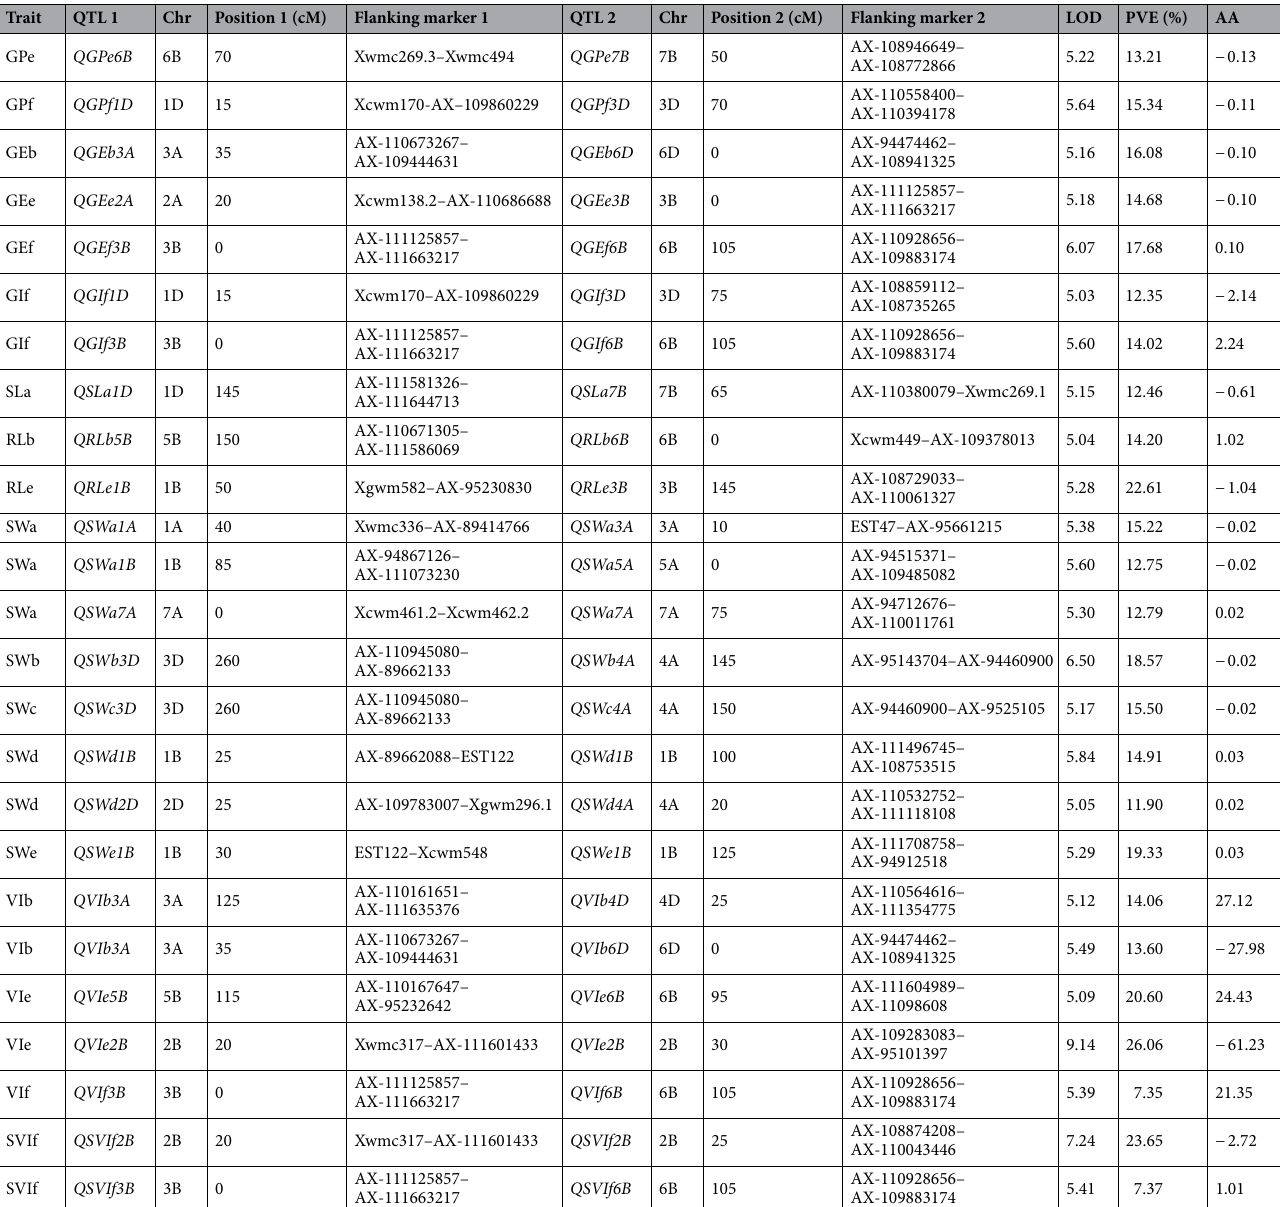
Table 2. Epistatic QTLs for seed vigor traits in wheat DH population. Positive value for epistatic effect means the greater genetic values of parental types than those of recombination types, while the negative value indicates the opposite scenarios. PVE = percentage of phenotypic variance explained by each QTL, AA = Additive-by-additive interaction